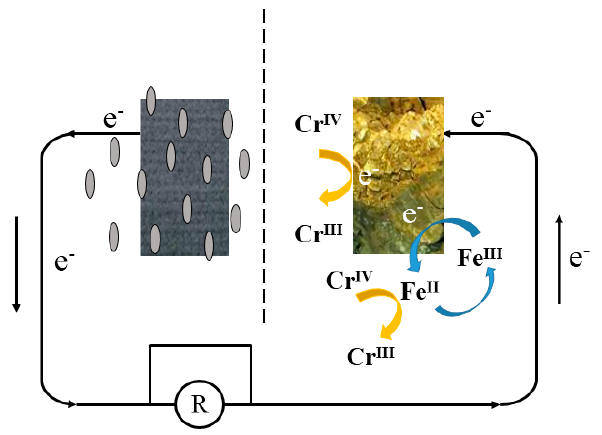
Figure 7. Schematic representation of t enhanced Cr (VI) removal by pyrrhotite-cathode MFC.